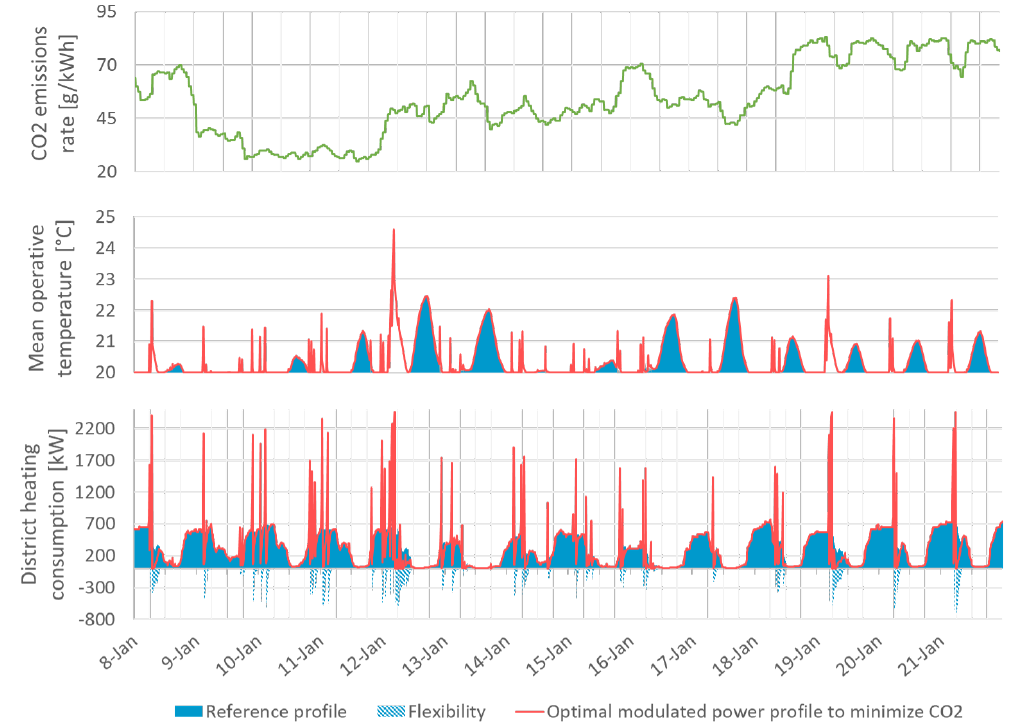
Figure 15. Optimal flexibility to minimize CO 2 emissions by allowing